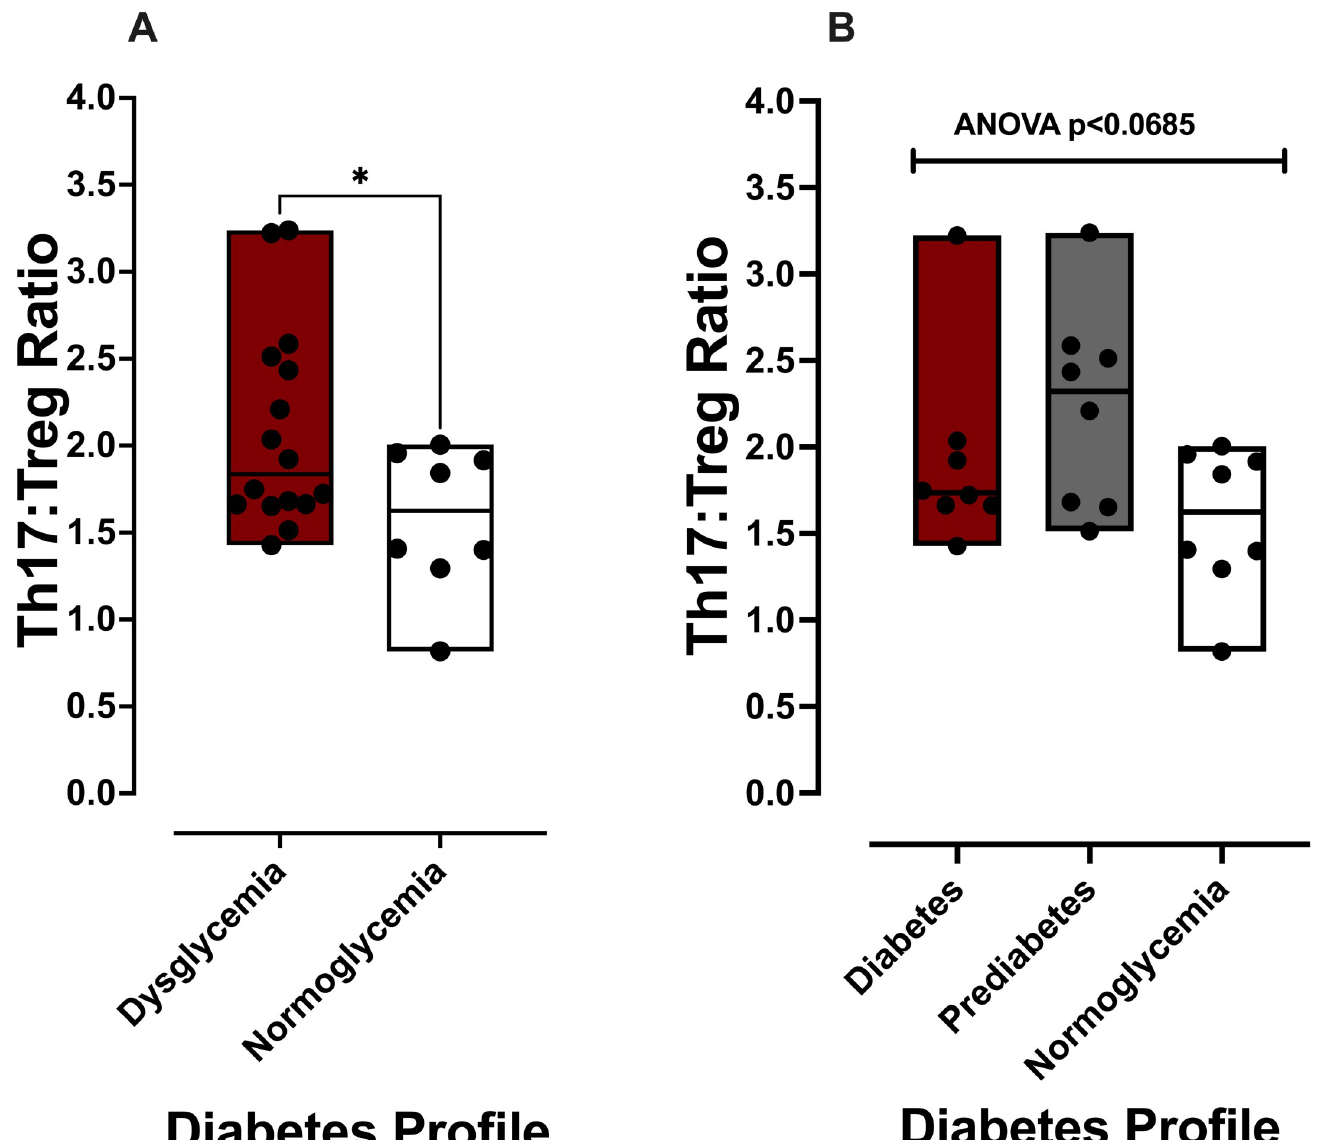
Fig 2. Th17:Treg ratios by diabetes profile. Box plots depict the median (center line in each box) and box boundaries represent the range. ( A ) Th17:Treg ratio comparisons between those with normoglycemia and dysglycemia; � p < 0.042 two-tailed t-test. ( B ) Th17:Treg ratio comparisons between those with normoglycemia, prediabetes, and diabetes; ANOVA p <